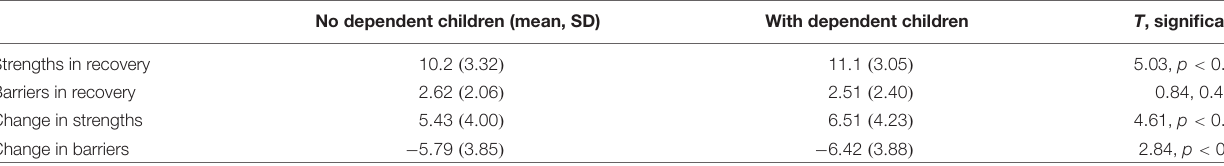
TABLE 5 | Mean number of strengths and barriers while in recovery and changes in strengths and barriers from addiction to recovery, by parenting status ( n = 1,313).